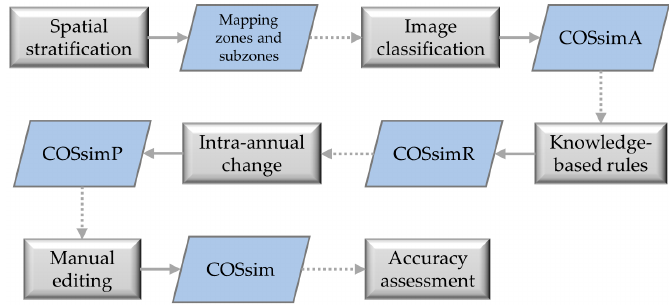
Figure 2. Overview of the methodology.